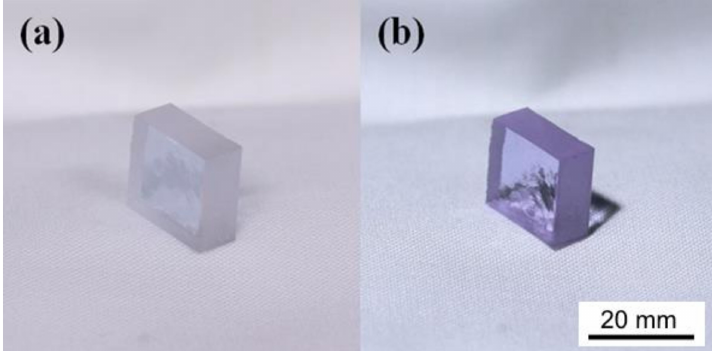
Figure 4. ( a ) As-cast Nd-doped phosphate glass illuminated by white neon light and ( b ) visible light